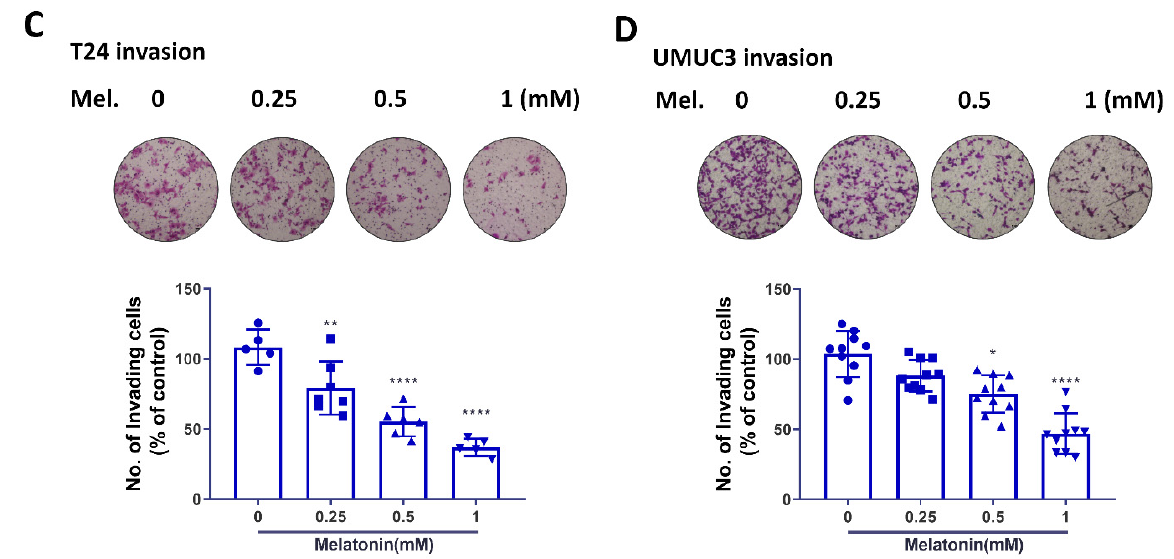
Figure 2. Melatonin suppressed migratory potential of bladder cancer cells. T24 and UM-UC-3 cells, treated with various concentrations of melatonin (0, 0.25, 0.5 and 1 mM), were further subjected to evaluation of cell migratory potential 24 h post-treatment. The in vitro migration ( A , B ) and invasion assays ( C , D ) were performed using the Transwell to determine cell migratory potential. The results are expressed as the mean ± SEM. * p < 0.05, ** p < 0.01, *** p < 0.001, and **** p < 0.0001 compared with the control group.